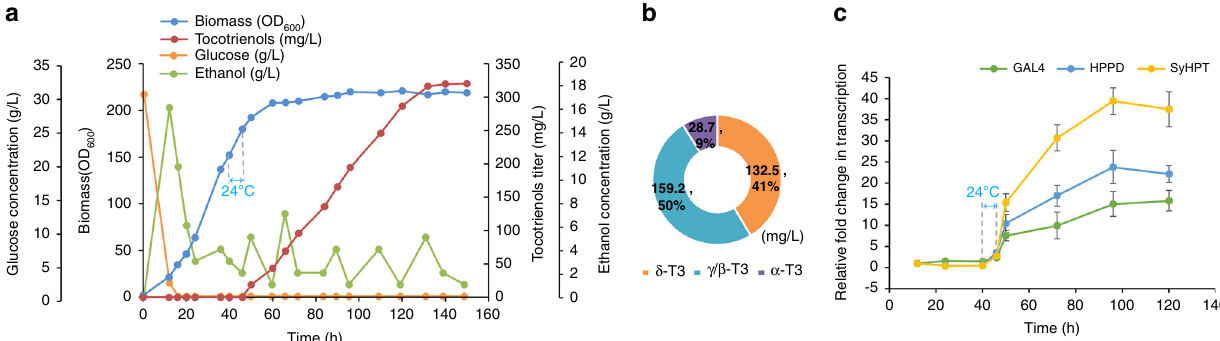
Fig. 8 Temperature-regulated high-density fermentation of tocotrienols by YS-M5GP3( + ). a Time courses of cell growth, tocotrienols production and consumption of carbon sources during temperature-regulated high-density fermentation of tocotrienols by YS-M5GP3( + ). The duration of cold shock at 24 °C is from 40 to 45th h. b Composition of tocotrienols produced by the end of YS-M5GP3( + ) fermentation. T3 is short for tocotrienol. c Transcription levels of GAL4/GAL4M9 , HPPD , SyHPT in YS-M5GP3( + ) during fermentation. All values presented are the means of three biological replicates, and error bars represent standard deviations. Source data are provided as a Source Data fi